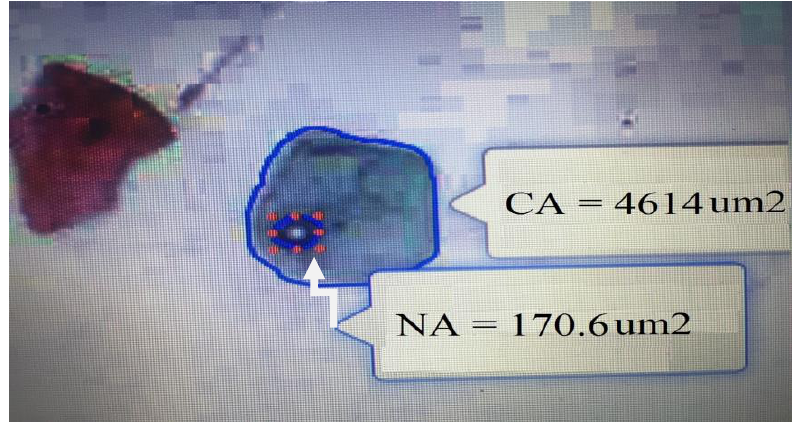
Figure 1: The encirclement of boundaries of the cytoplasm and the nucleus of then suprabasal cells case on digital images